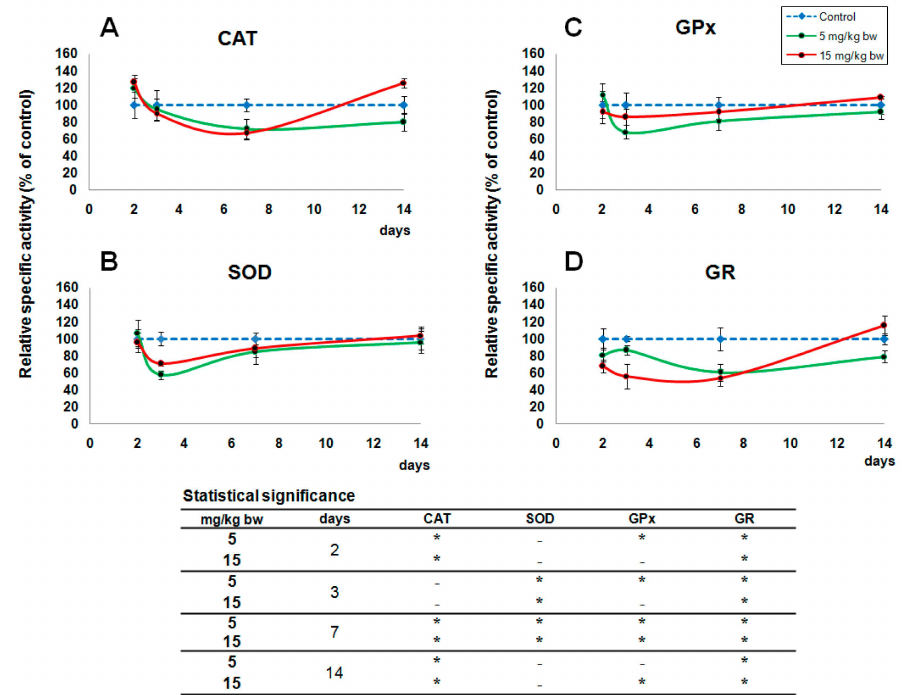
Figure 4. Effects of exposure to IONPs-PM on CAT ( A ); SOD ( B ); GPx ( C ); GR ( D ) in mice lung tissue. Activities are calculated as means ˘ standard deviation ( n = 7) and expressed as % from controls. * Means significantly different from controls ( p < 0.05, α (significance level) =